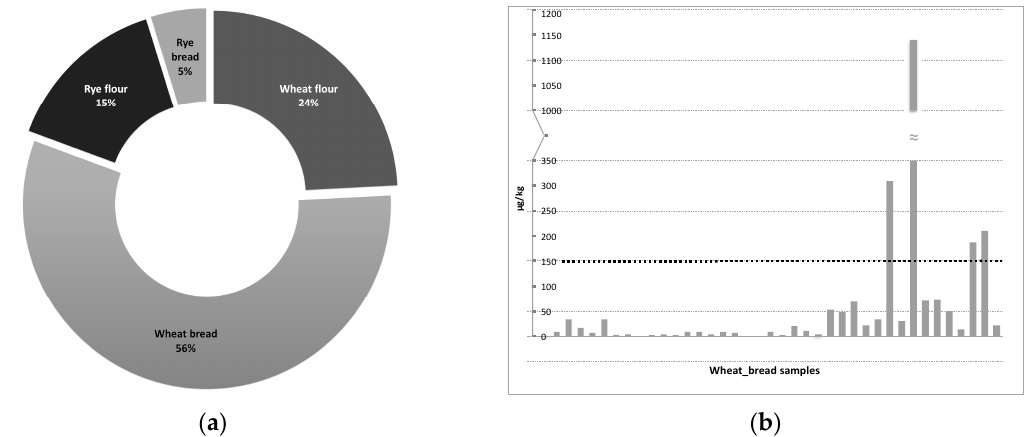
Figure 3. ( a ) Distribution (percentages) of the positive samples among the collected sample categories. ( b ) EAs contamination level in wheat bread samples, expressed as the sum of the 12 EAs analysed ( μ g/kg). The dotted line representing a possible EU maximum level for products intended for direct human consumption.